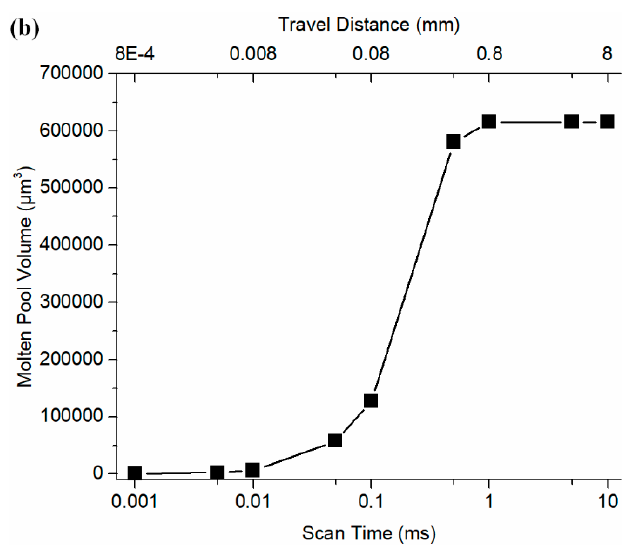
Figure 5. The growth and stabilization of the predicted molten pool in single track scan using the determined absorption of 40% in terms of ( a ) molten pool length, molten pool width, and molten pool depth, and ( b ) molten pool volume.